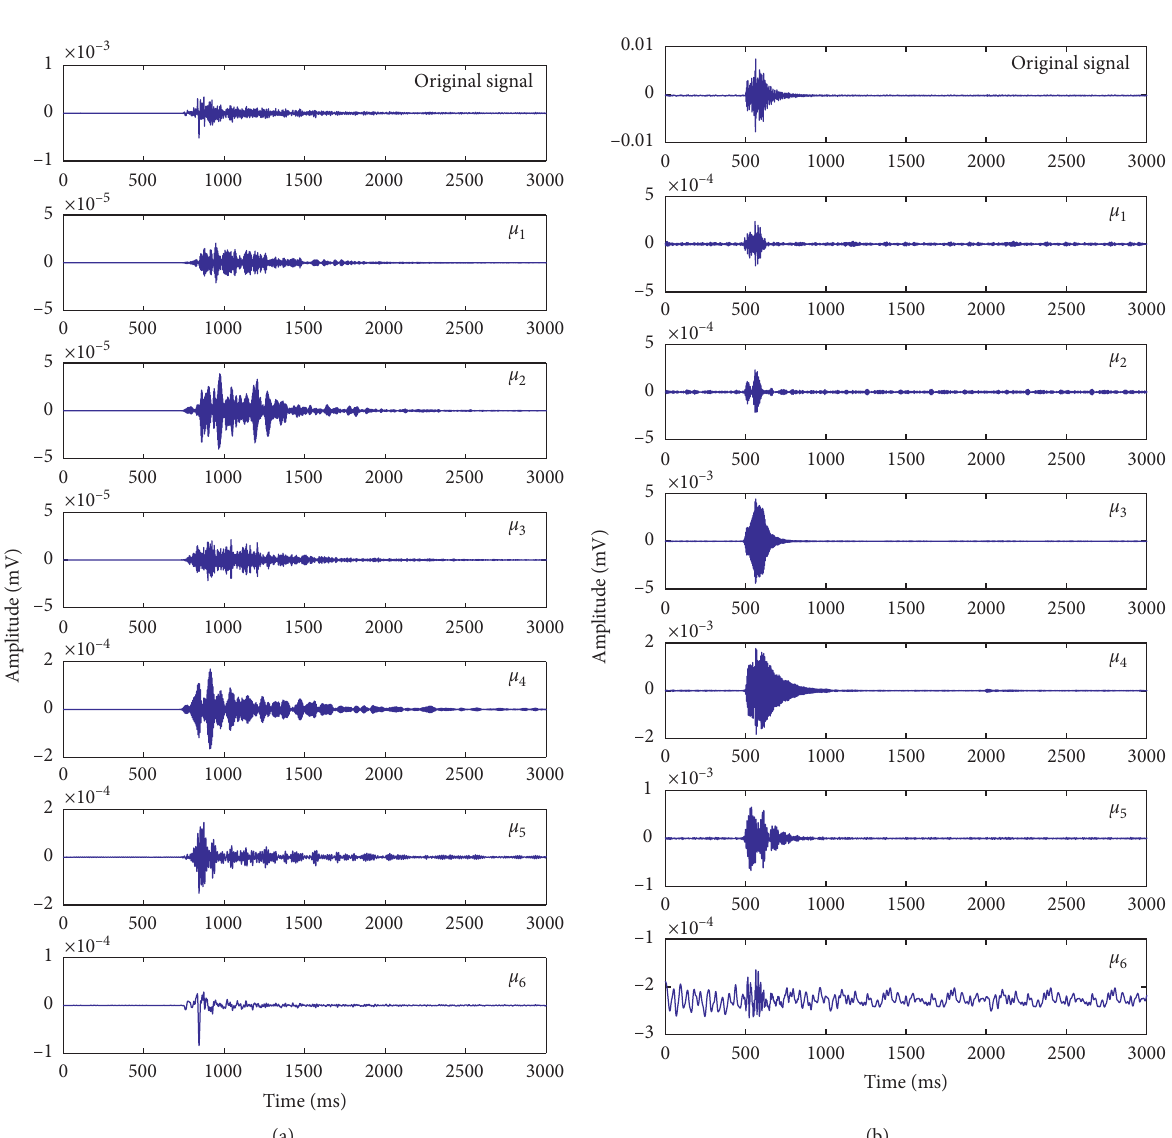
Figure 3: Original signals and VMD decomposition results. (a) The rock fracture microseismic signal. (b) The blasting vibration